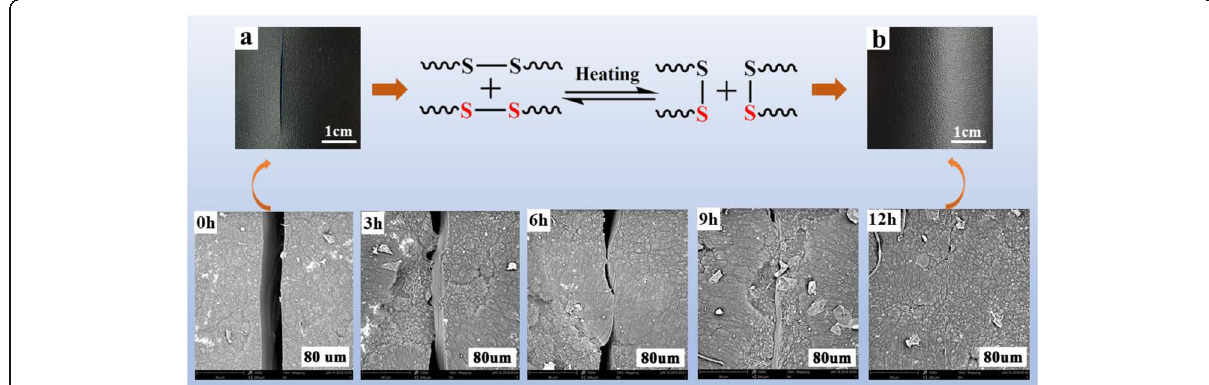
Fig. 4 Self-healing process of leather coating: ( a ) damaged leather coating; ( b ) leather coating after be repaired at 60 °C for 12 h; SEM image is the self-healing process of damaged leather coating